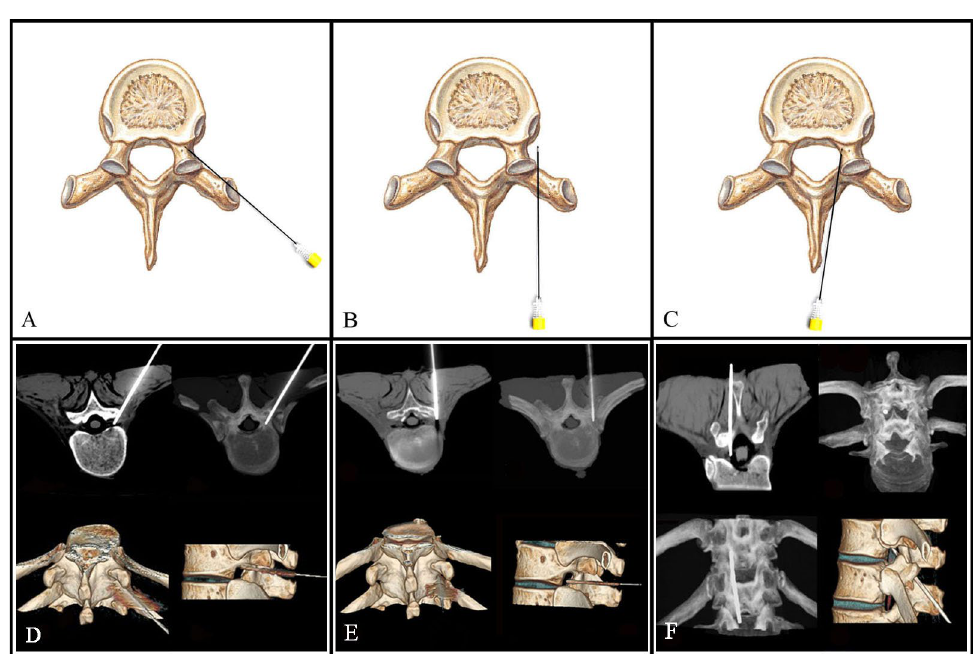
Figure 3. ( A ) Schematic of transforaminal approach; ( B ) Schematic of trans-lateral-zygapophysial approach; ( C ) Schematic of translaminar approach. ( D ) Puncture DRG via a transforaminal approach. CT 3D reconstruction shows position of the needle. ( E ) Puncture DRG via a trans-lateral-zygapophysial approach. ( F ) Puncture DRG via a translaminar